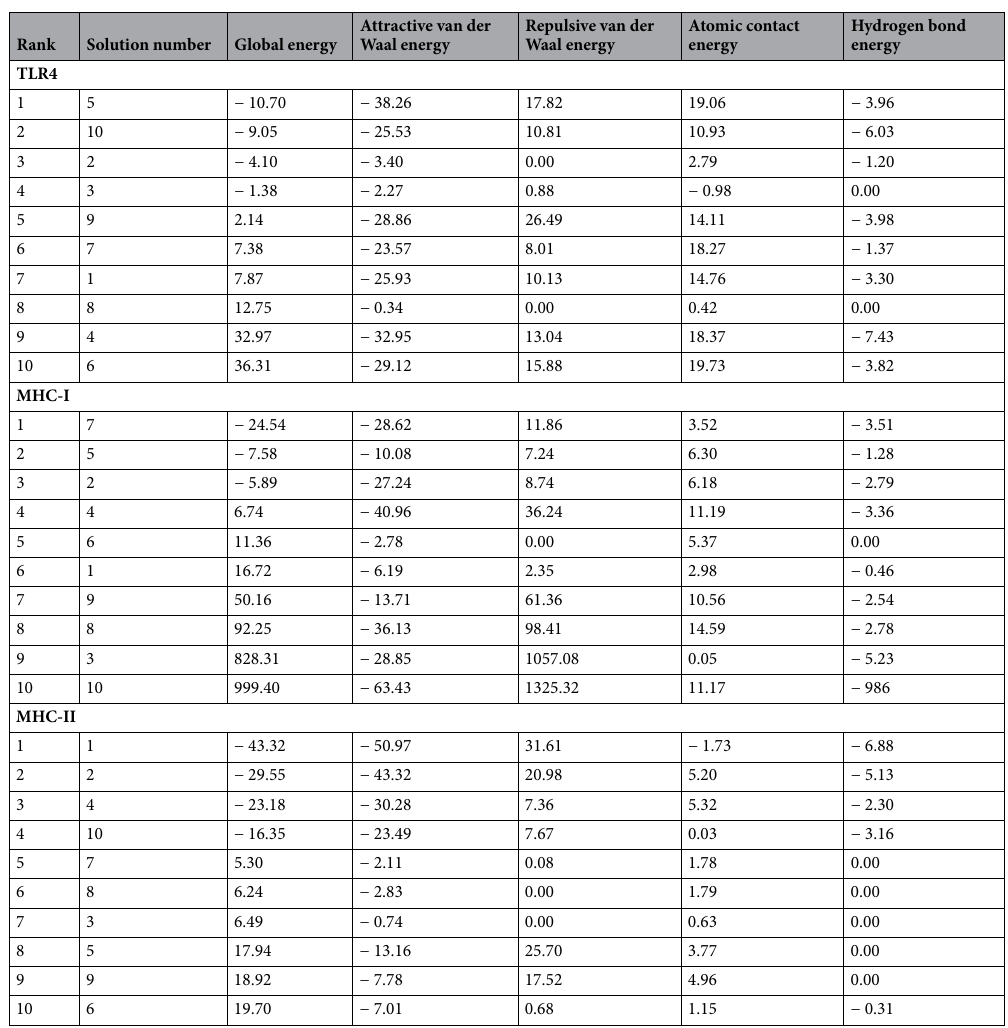
Table 3. Ranking of docked solutions based on different scoring